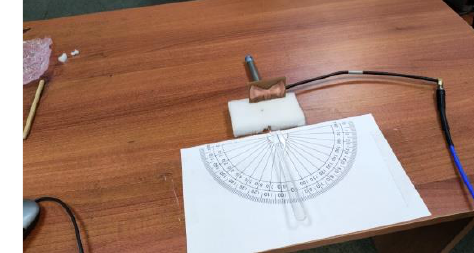
Figure 7. Measurement setup Figure 8. Bow-tie antenna with protractor for